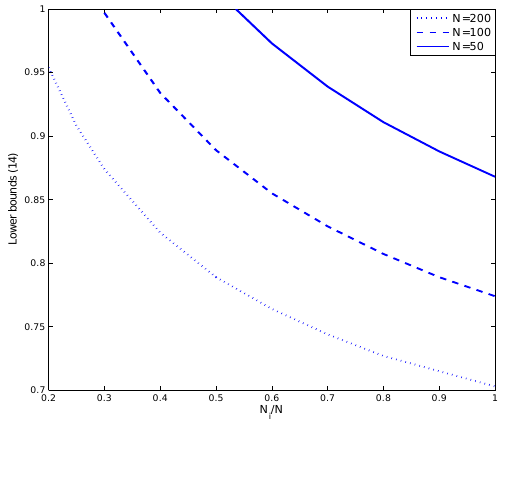
Fig. 3. Lower bounds (14) versus the parameter Ni/N of secondary network. = 0.1 and ni =